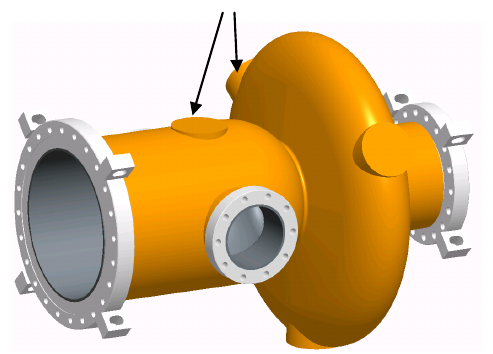
FIG. 17. 3D model of the cavity after electroforming a 6 mm thick Cu layer on the outer